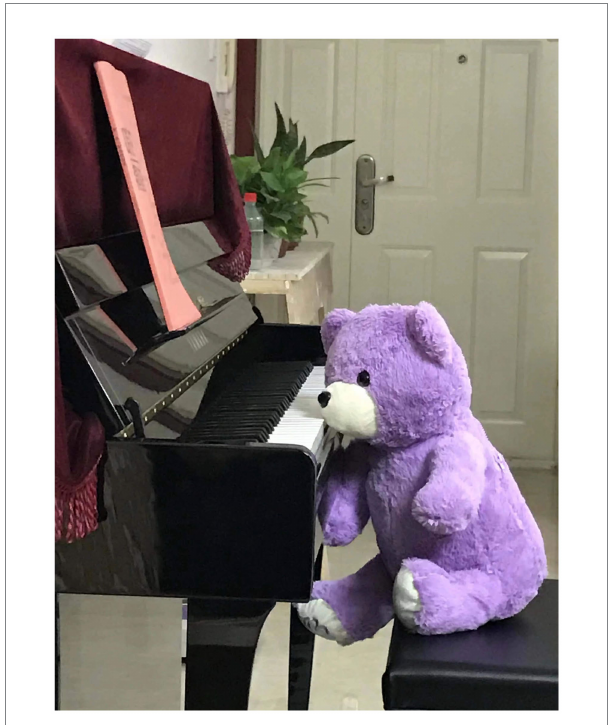
FIGURE 1 Liang’s photo (a long-time-no-use piano sitting beside a teddy